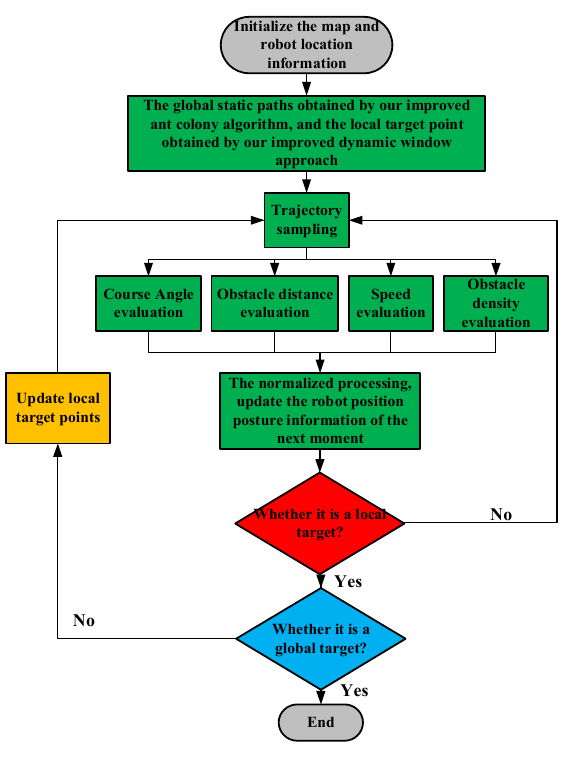
Figure 10. Fusion algorithm flow.